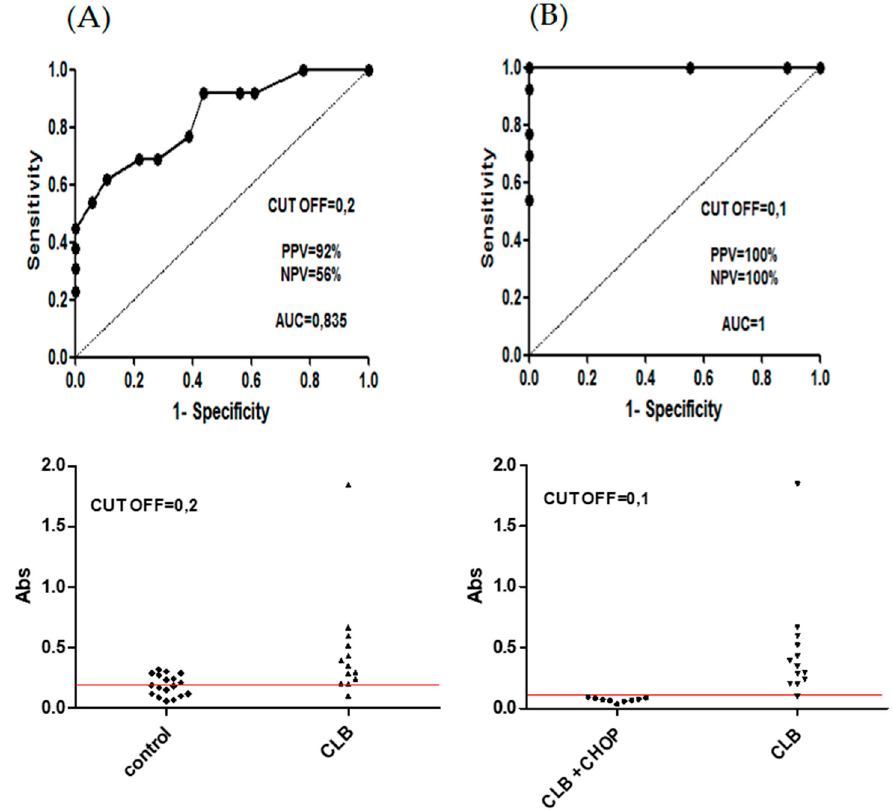
Figure 6. Evaluation of the diagnostic potential of soluble DLA-DR levels in canine CBL patients versus healthy control dogs ( A ), and in CBL patients versus post-chemotherapy patients ( B ). Receiver operating characteristics analysis was used to determine sensitivity, specificity, positive predictive value (PPV), negative predictive value (NPV), area under the curve (AUC) value and cut off (CUT OFF) value for the soluble DLA-DR immunoassay.